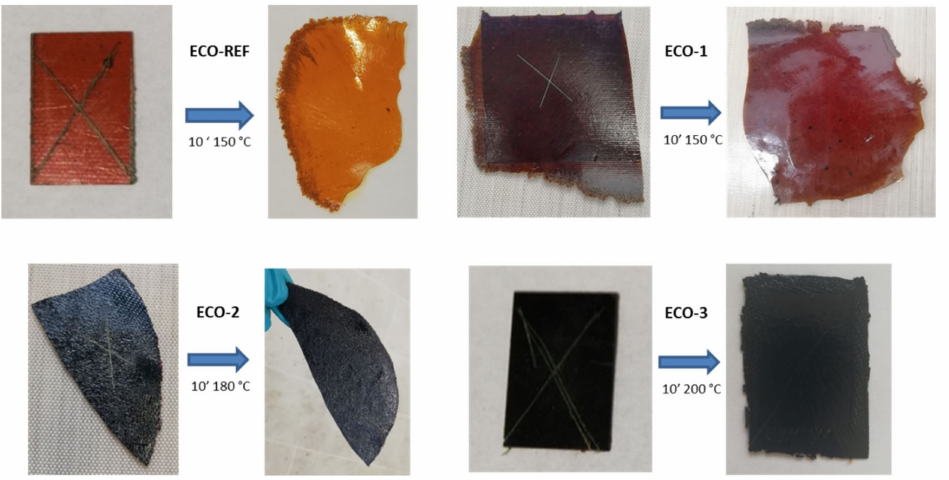
Figure 6. Repairing of the prepared materials by applying heat and pressure for 10 (cid:48) at: 150 ◦ C (ECO-1); 180 ◦ C (ECO-2); and 200 ◦ C